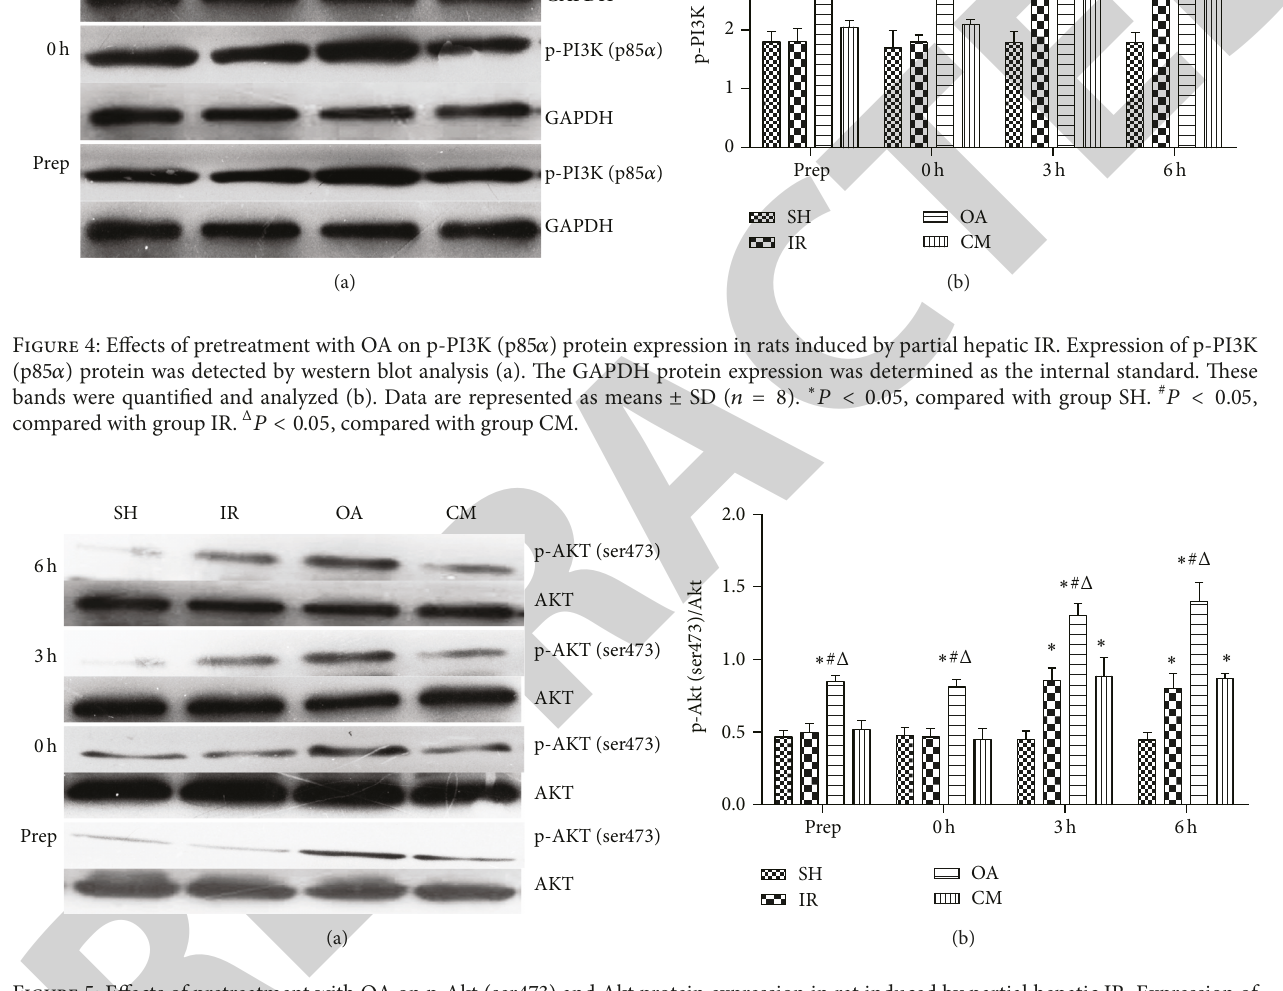
Figure 5: Effects of pretreatment with OA on p-Akt (ser473) and Akt protein expression in rat induced by partial hepatic IR. Expression of p-Akt (ser473) and Akt protein was detected by western blot analysis (a). These bands were quantified and analyzed (b). Data are represented as means ± SD ( 𝑛 = 8 ). ∗ 𝑃 < 0.05 , compared with group SH. # 𝑃 < 0.05 , compared with group IR. Δ 𝑃 < 0.05 , compared with group